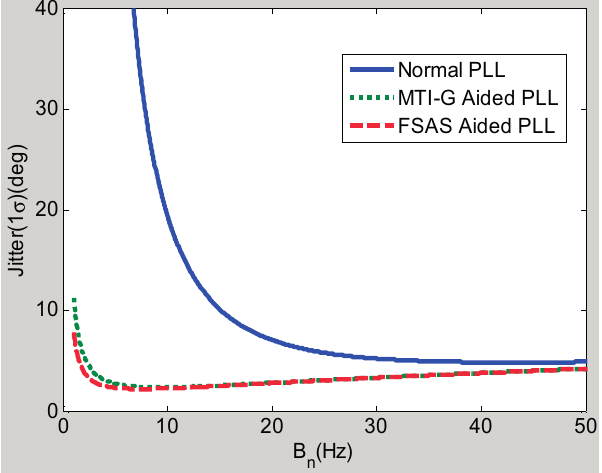
Figure 8. Steady-state tracking errors with the acceleration of 9.8 m/s 2 and CNR of 40 dB-Hz.